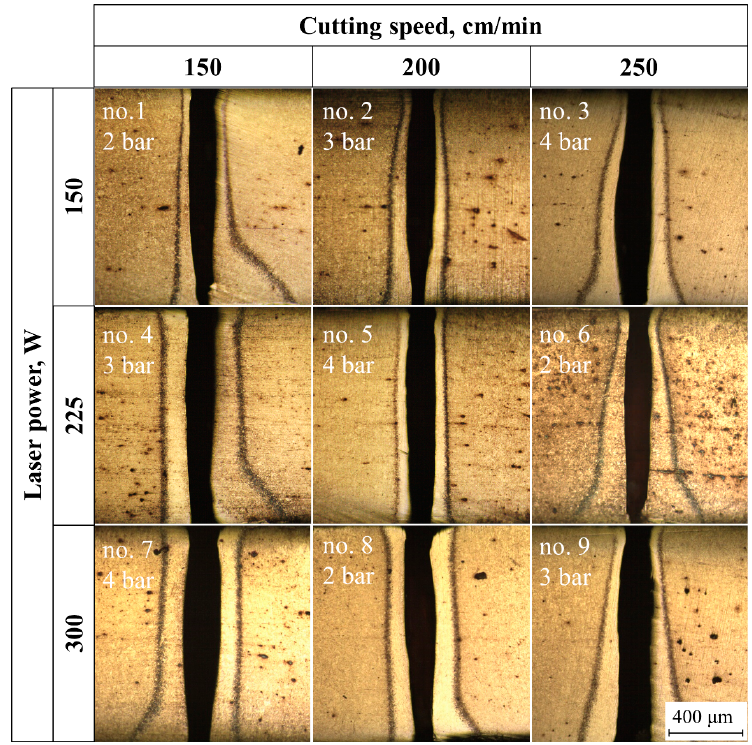
Figure 4. Cross sectional area of the cut surfaces for the different cutting conditions.